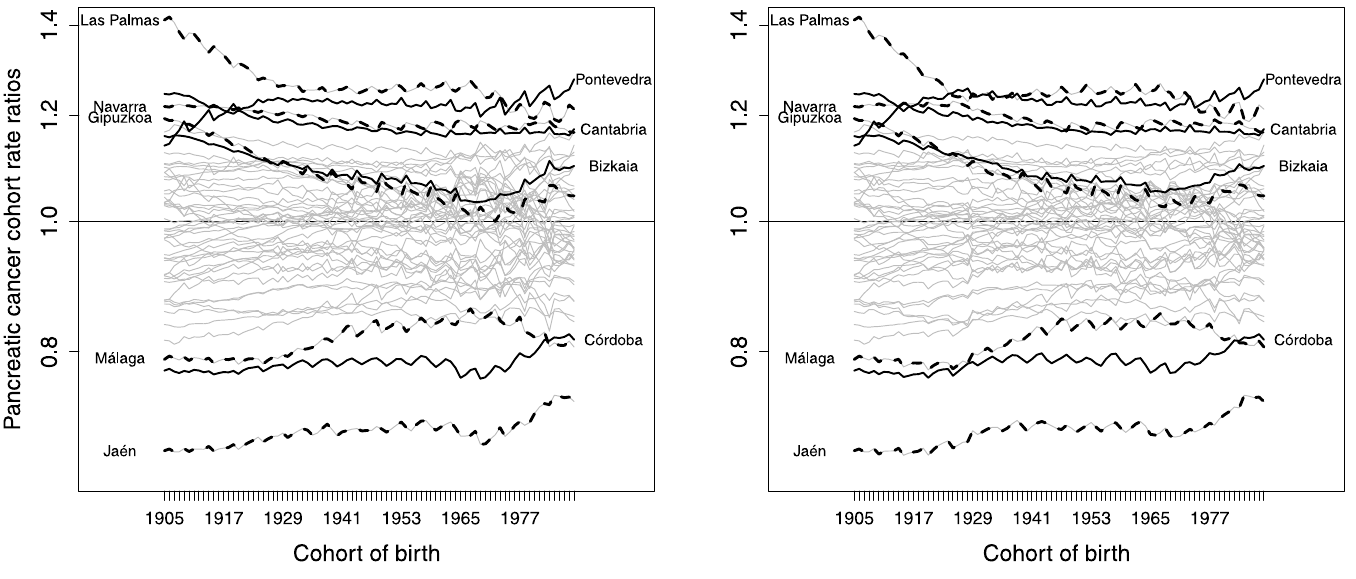
Fig 5. Ratios of region-specific averagerates by birth cohort relative to the averagerates by birth cohort for whole Spain (males on the left and females on the